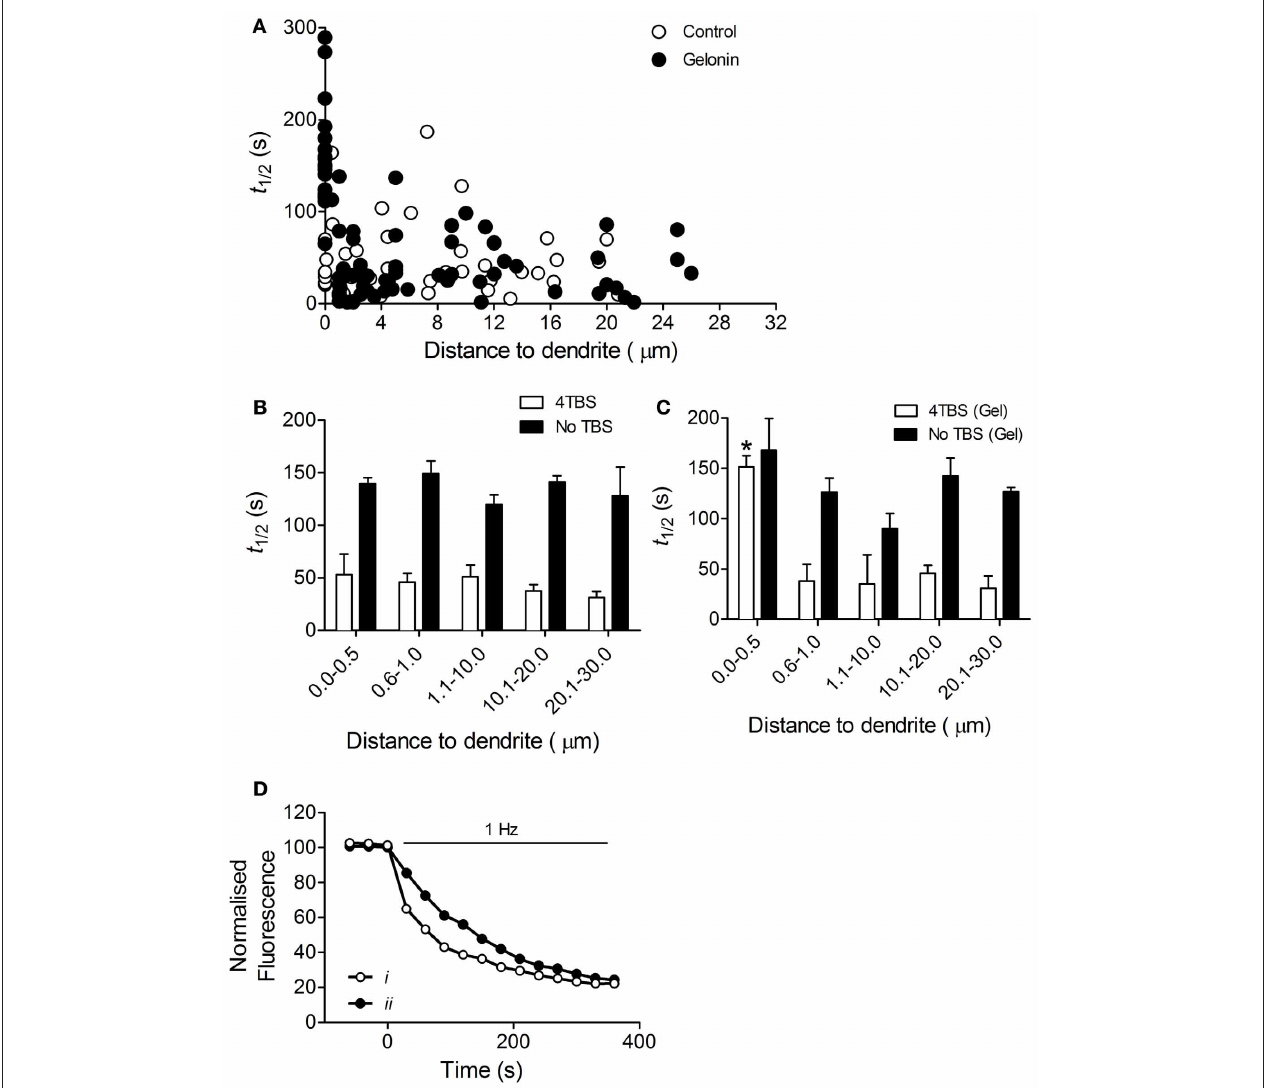
FIGURE 3 | Enhanced presynaptic function associated with LTP2 is dependent on postsynaptic translation. (A) Scatter plot showing the half-life of FM 1-43 destaining versus distance to filled dendrite for individual terminals in slices stimulated with 4TBS with and without gelonin in the patch pipette. (B) Histogram summarizing destaining rate data from the “Control” group in (A) and from “No TBS” slices with distances binned. Destaining rate was enhanced in slices stimulated with 4TBS and there was no effect of distance to nearest postsynaptic dendrite in these untreated cells. (C) Histogram of data obtained from 4TBS